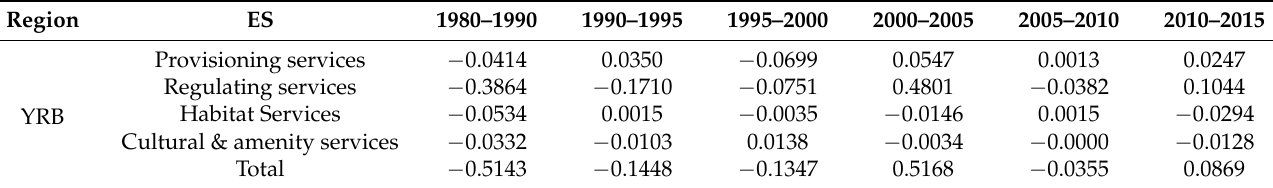
Table A5. ESV change rate (billion USD/a) in different